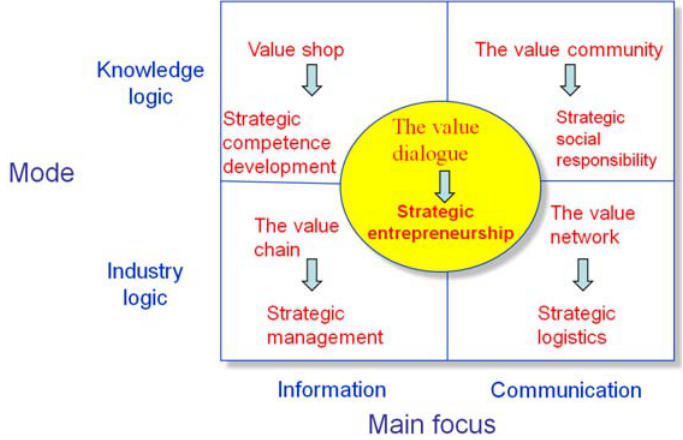
Fig. 4. The five value creation